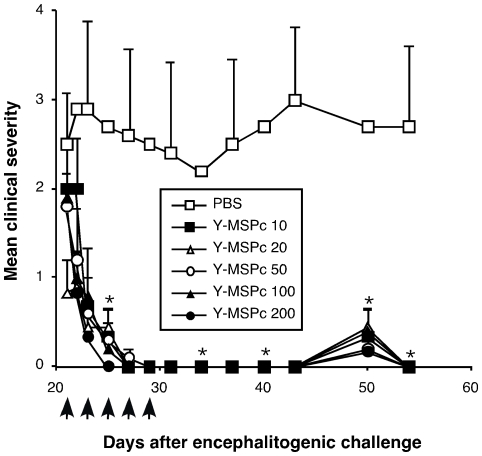
Effective reversal of ongoing PLP139-151-induced EAE by treatment with low doses of Y-MSPc.BSF1 mice were induced to develop “classical” EAE with PLP139-151. Starting on day 21 after immunization (6–8 days after disease onset), mice with a clinical score of at least 2 were grouped into groups with equal mean clinical score (5 mice/group) and treated with indicated doses of Y-MSPc in PBS (0.5 ml) or with PBS alone on days indicated by the arrows. Results shown are the mean clinical score +/−SE of one representative experiment out of two independent experiments showing a similar pattern; *, p<0.05 compared to PBS control group; two tailed Student's t-test.